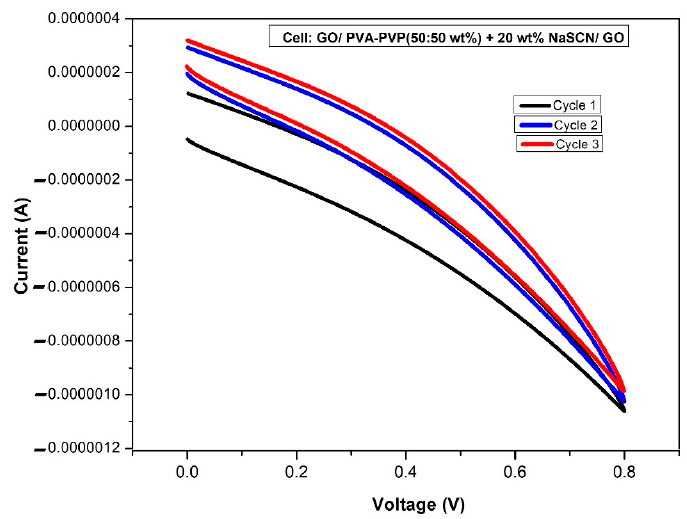
Figure 11. CV plot of the supercapacitor based on the optimized polymer-salt blend electrolyte film recorded at a scan rate 50 mV/s over the potential range 0–0.8 V for the three first cycles.-